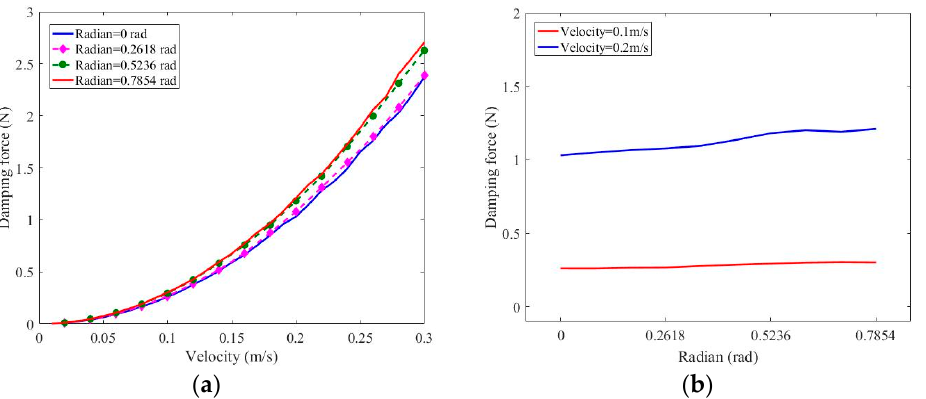
Figure 5. The relationships between damping force, surge velocity and deflection angle in surge direction. ( a ) Damping force surge velocity; ( b ) Damping force deflection angle. In Figure 5a, the hydrodynamic damping force on the robot had an approximate quadratic relationship with the surge velocity at the same deflection angle. The damping forces on the robot were also slightly affected by different deflection angles. The detailed relationship between the damping force and the deflection angle is shown in Figure 5b. At the same surge velocity, the damping force increased as the robot deflection angle changed from 0 to 45 degrees. This law was related to the structure of the robot itself.